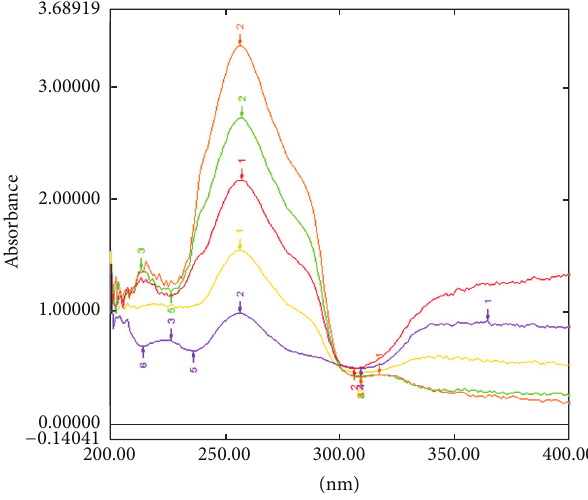
Figure 7: Ratio spectra of PRA (6–22 𝜇 g/mL) using 75 𝜇 g/mL solution of ASP as